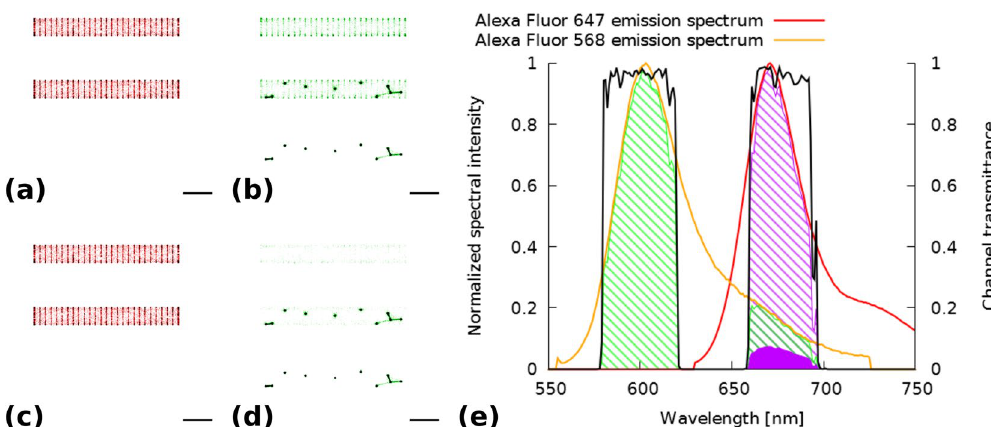
Figure 3. Spectral crosstalk between actin rings and vesicles labelled by Alexa 647 and Alexa 568 dyes, respectively, using a single multiband filter set and excitation of 647 nm ( a , c ) and 561 nm ( b , d ). Additional thresholding of the accepted localizations based on their photon number can reduce the crosstalk ( c , d ). Emission spectra of Alexa 568 (orange) and 647 (red) filtered by the multiband emission filter (black). Scale bar is 1